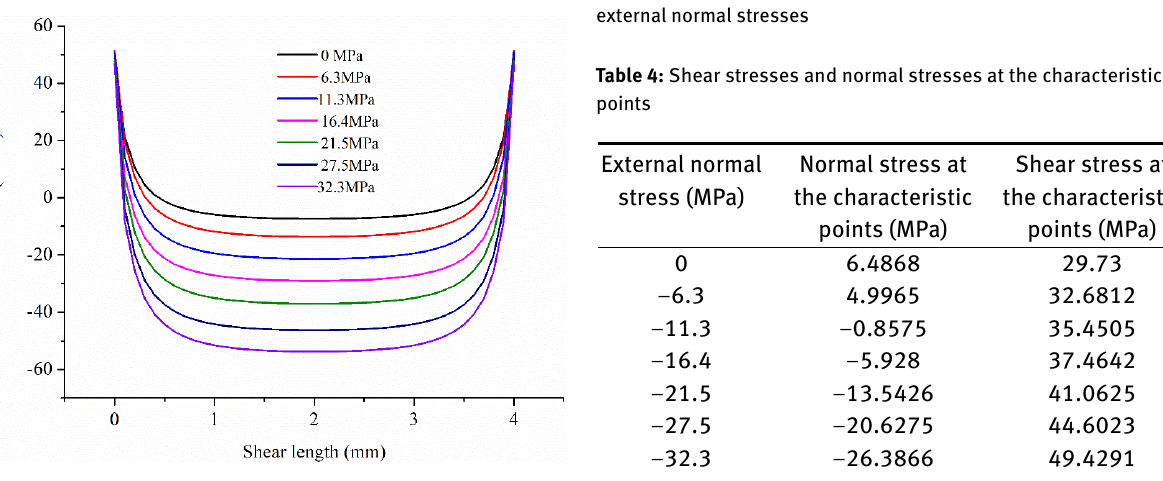
Figure 13: Normal stress distribution of specimen under different external normal stresses